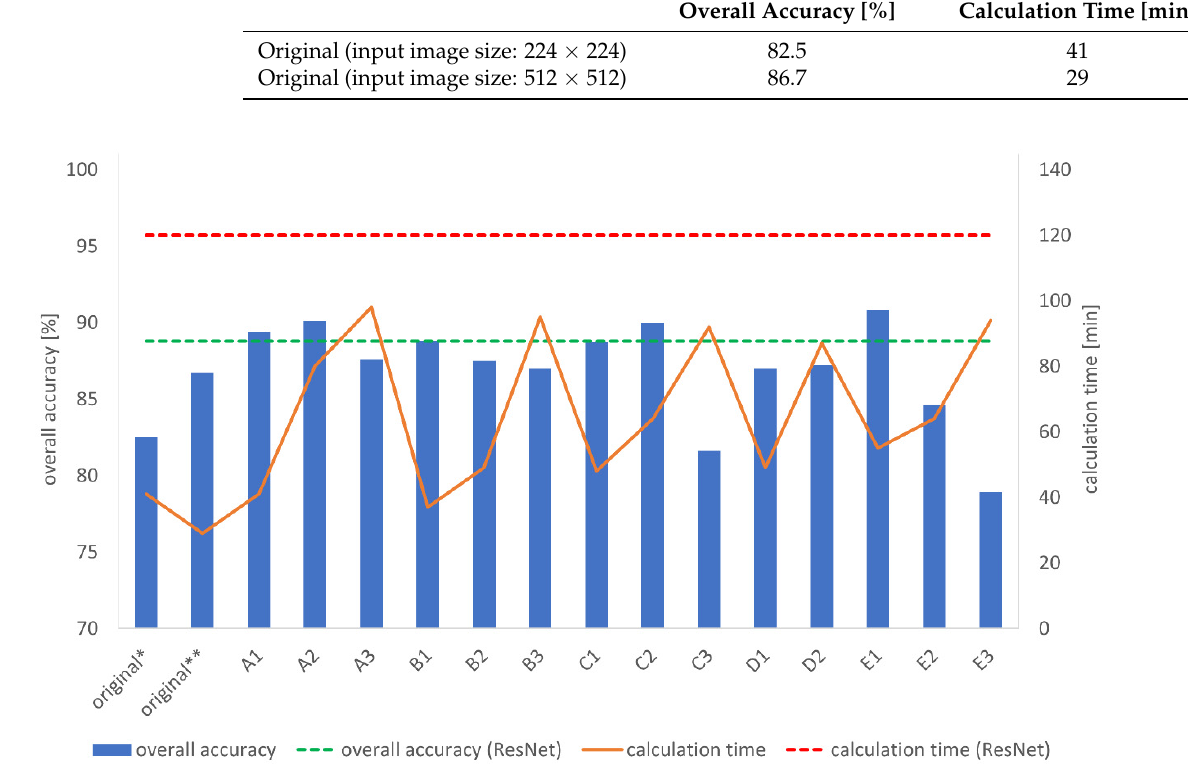
Figure 4. Overall accuracies and calculation times of the models in which the filter sizes of the convolution layer were changed (original *: original (input image size: 224 × 224), original **: original (input image size: 512 × 512)).